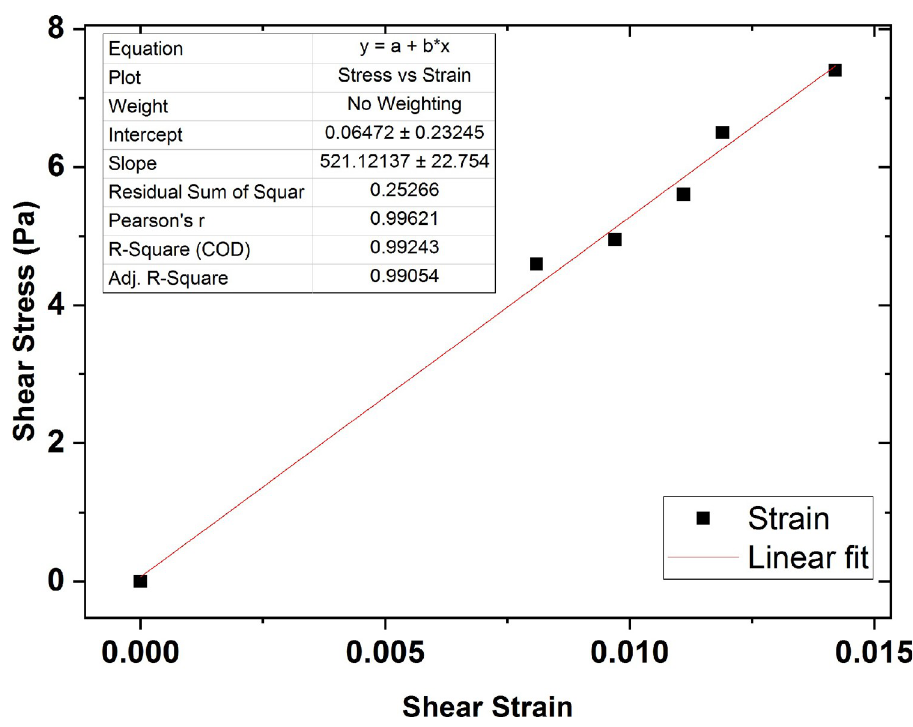
Fig 16. The graph of shear stress versus shear strain for the collagen gel of 0.5 wt % percent concentration.